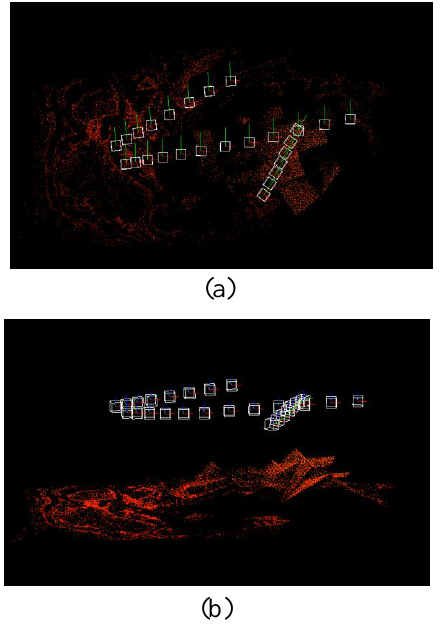
Figure 6. A top-view and (b) a side-view of the UAV image dataset and the reconstructed sparse point cloud